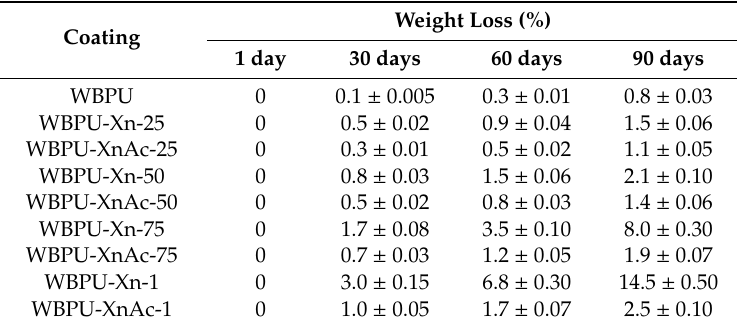
Table 4. Weight loss of immersed coatings at defined interval (day).